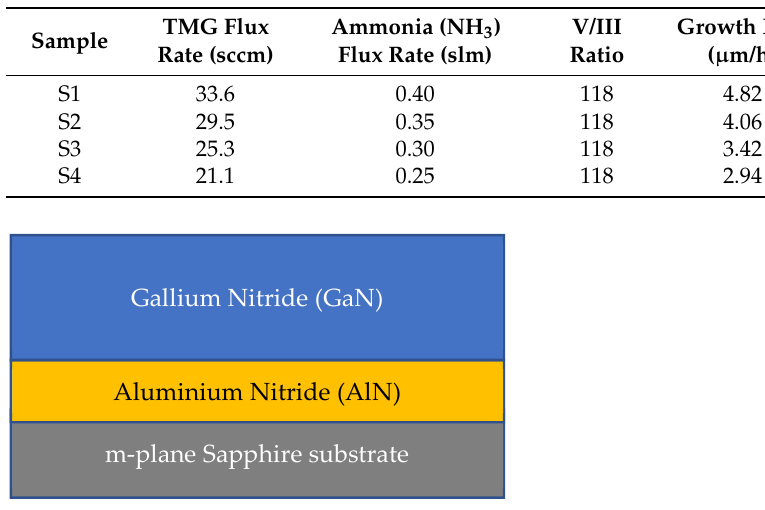
Figure 1. GaN with AlN nucleation layer grown on the m -plane sapphire substrate. Table 1. Growth parameters variation adapted in this work.